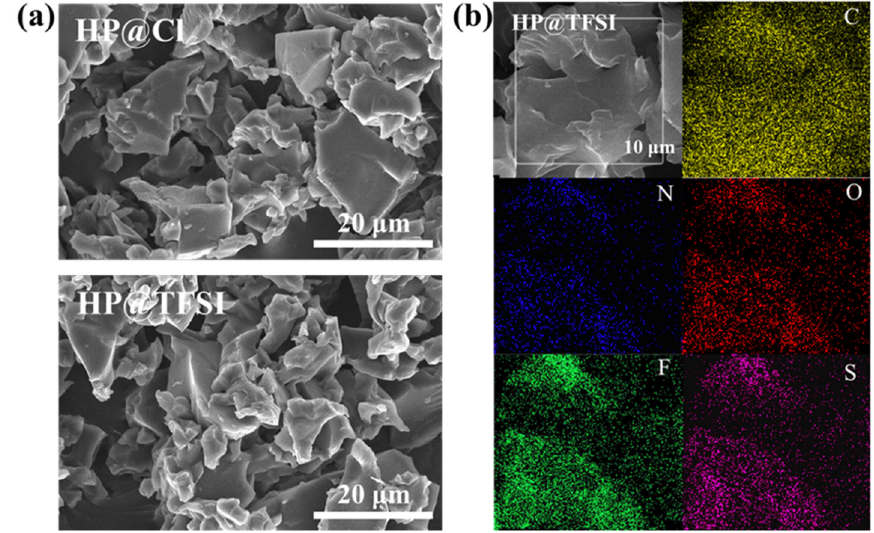
Figure 2. SEM images of ( a ) HP@Cl and HP@TFSI; ( b ) EDS mapping of